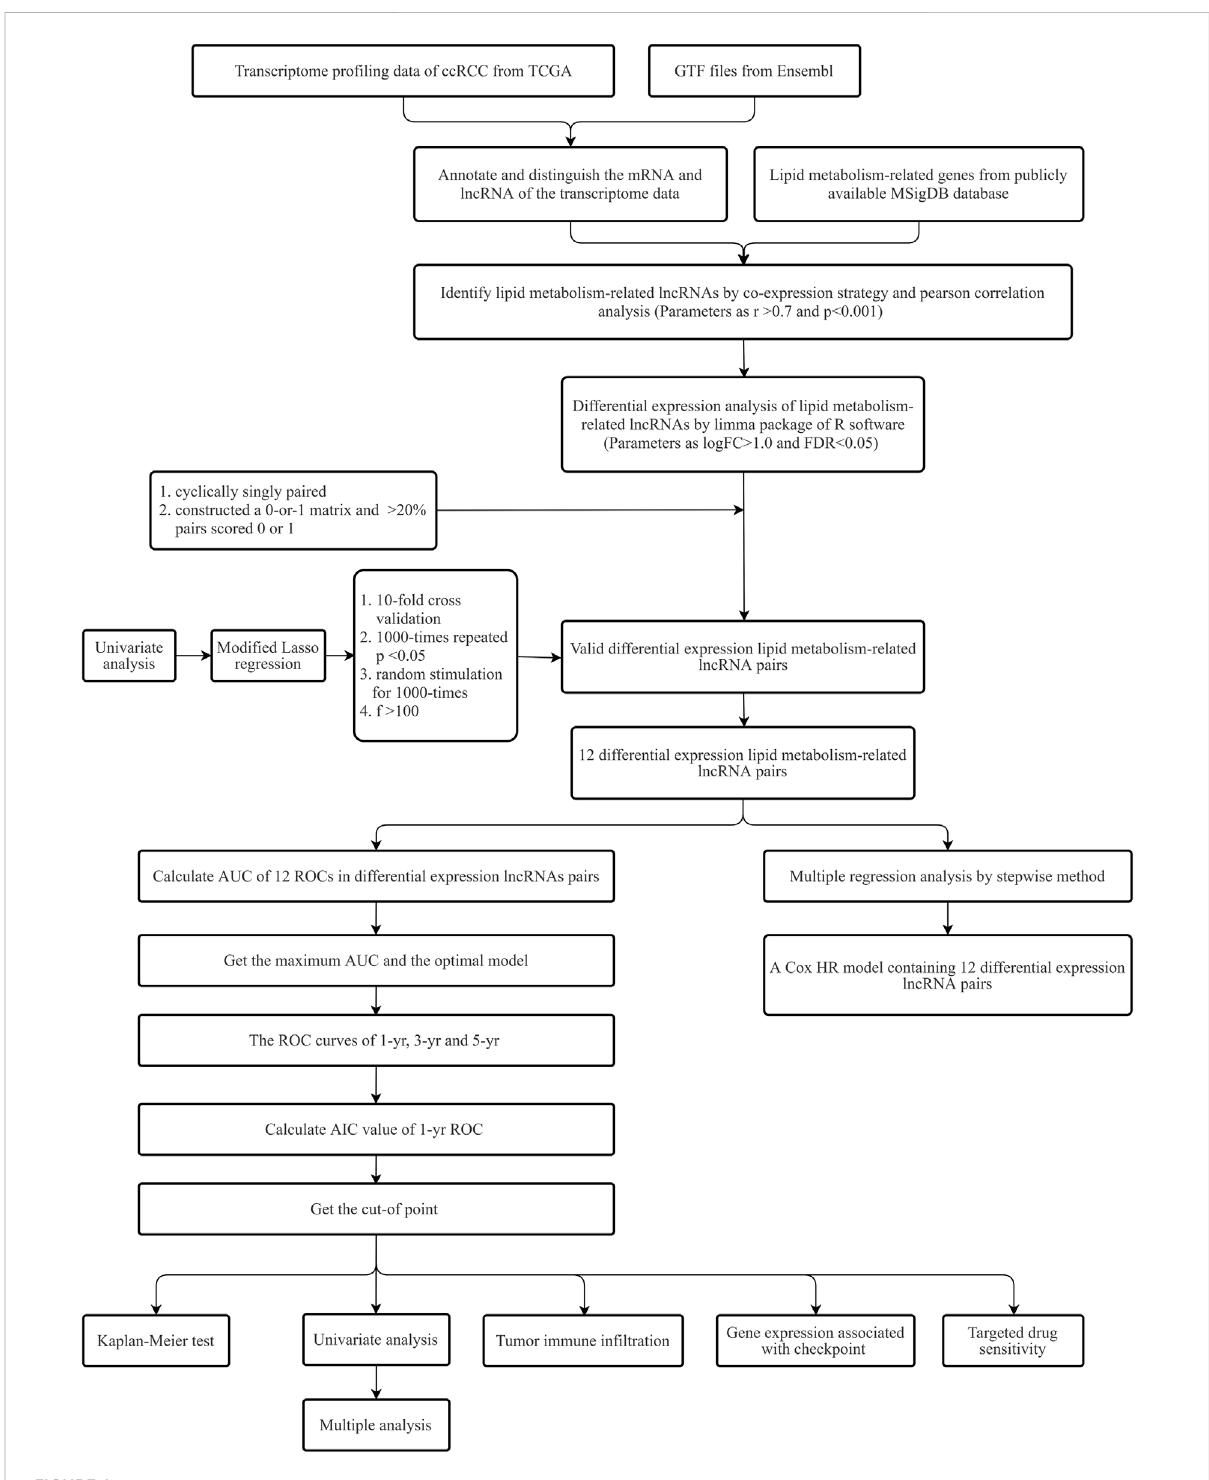
FIGURE 1 The process fl ow of the present